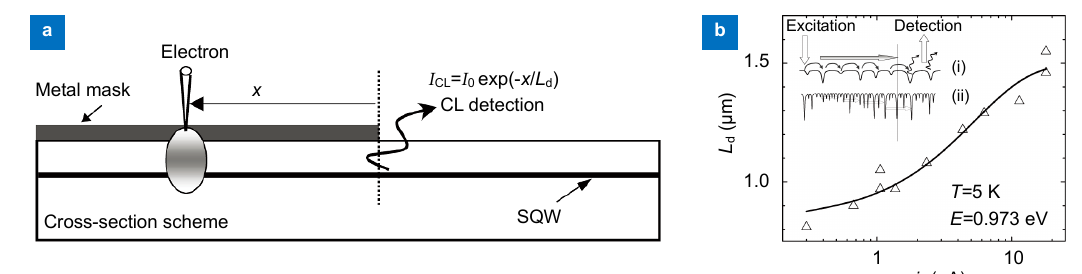
Fig. 3 | ( a ) Schematic of CL method for the measurement of L d . ( b ) L d as a function of the electron-beam current i b at 5 K. Inset: Schematic of the carrier transport in conjunction with localized states for low (i) and high (ii) densities of localized states. Figure reproduced from ref. 57 , John Wiley & Son.